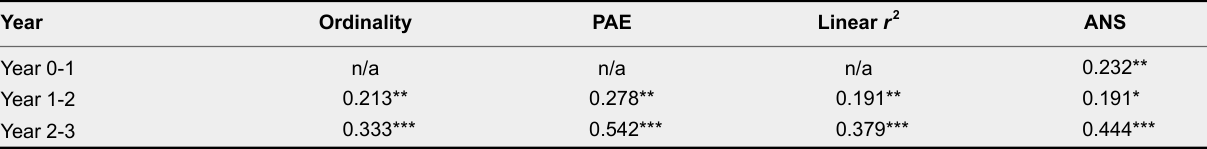
ANSLinear r 2 PAEOrdinalityYear